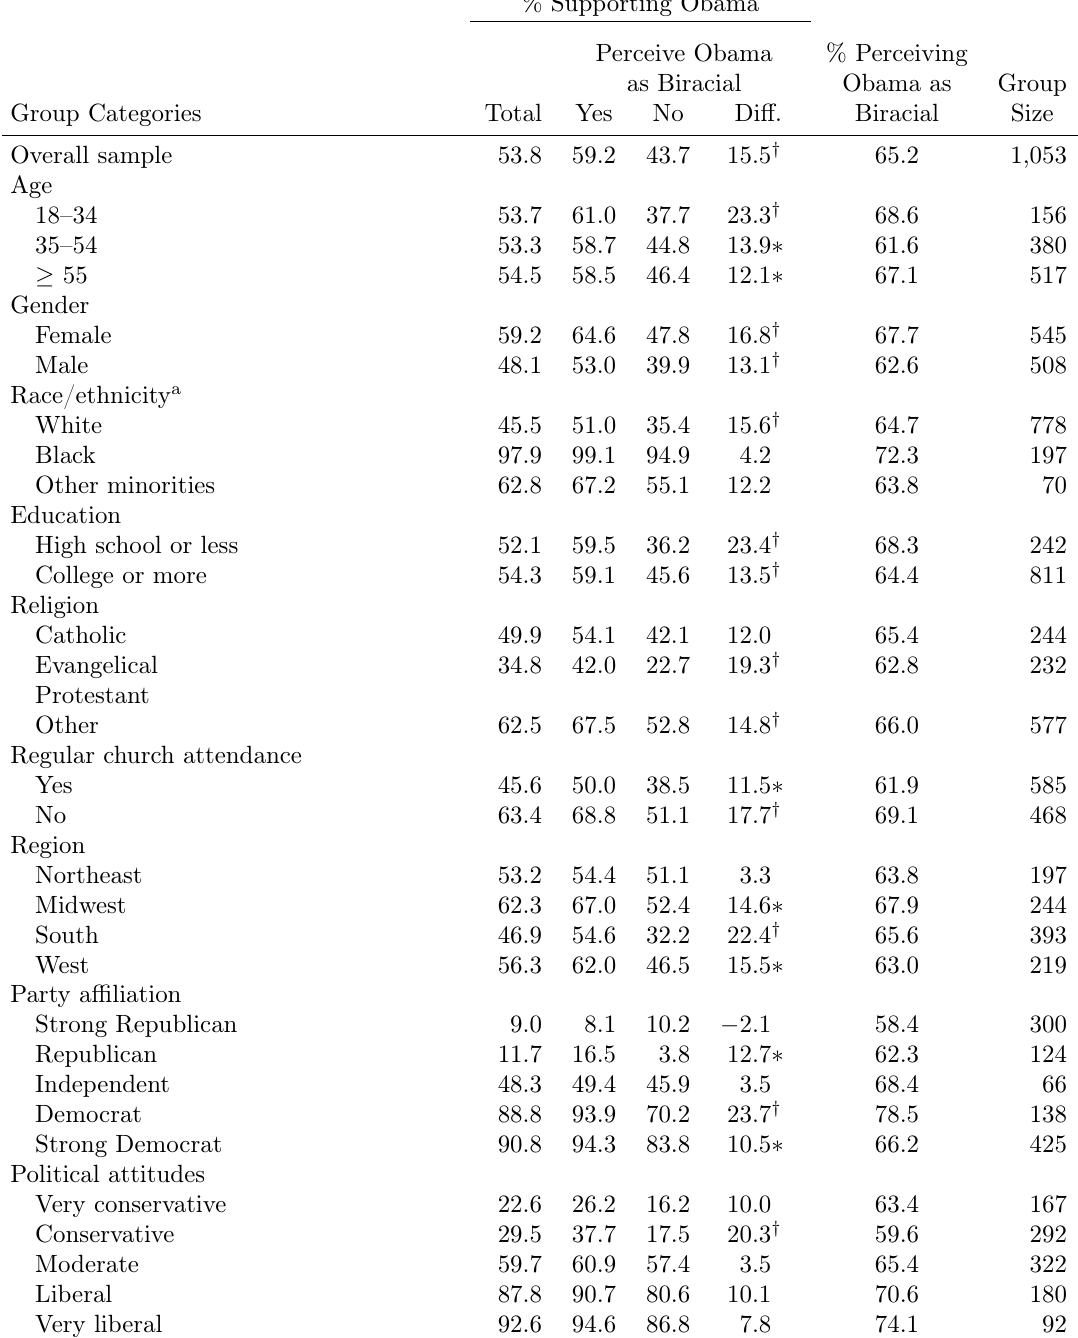
Table 2: Support for Obama in the Presidential Election and Perception of Obama as Biracial by Selected Sociodemographic